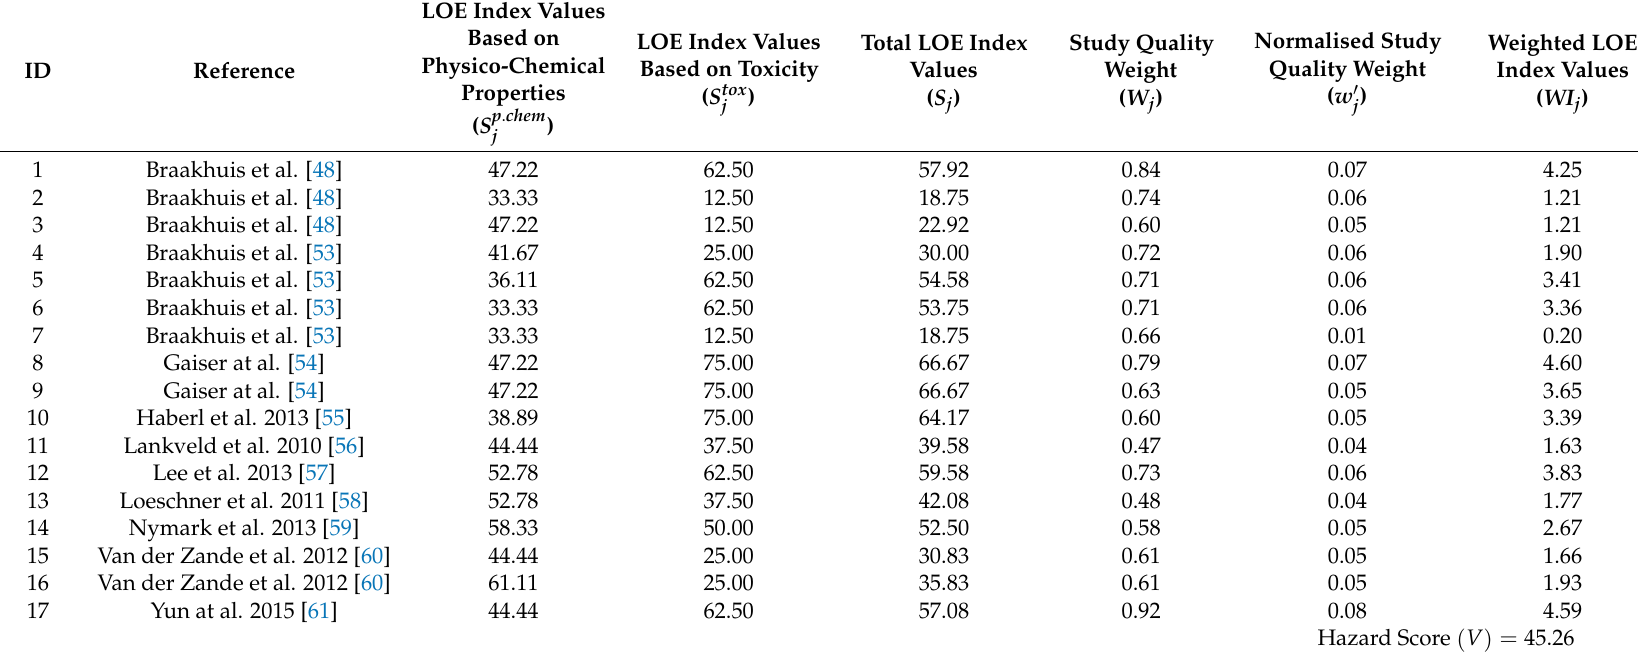
Table A1. Quantitative WoE results for nano-Ag. Each LOE represents experimental evidence from academic literature evaluated based on physico-chemical properties, toxicity, and study quality. The overall hazard of nano-Ag ( V ) is derived from sum of all LOE-specific hazard scores ( WI j